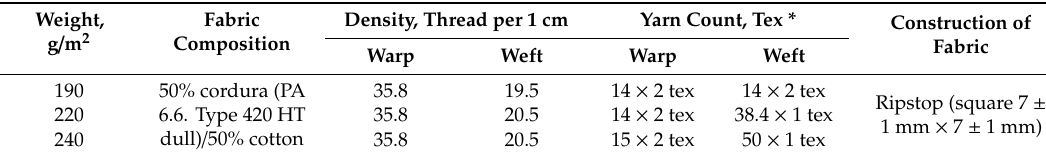
Table 1. Mechanical properties of investigated